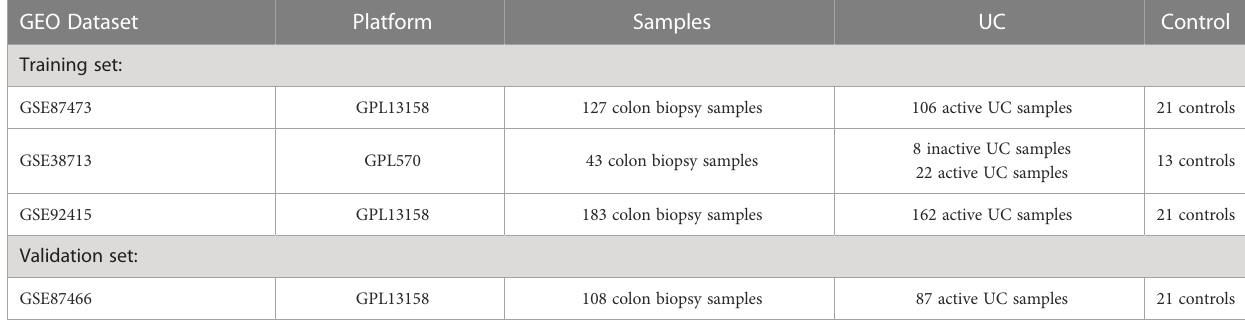
TABLE 1 Basic information about the microarray data set for ulcerative colitis. GEO